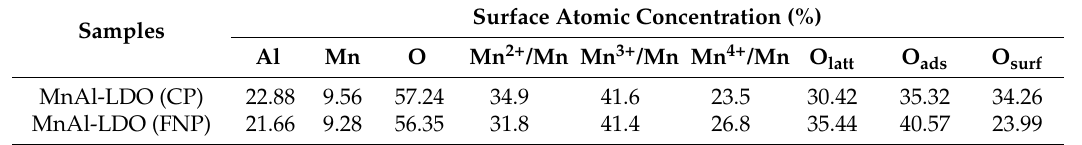
Table 2. Surface atomic concentration of various elements in MnAl-LDO (CP) and MnAl-LDO (FNP)